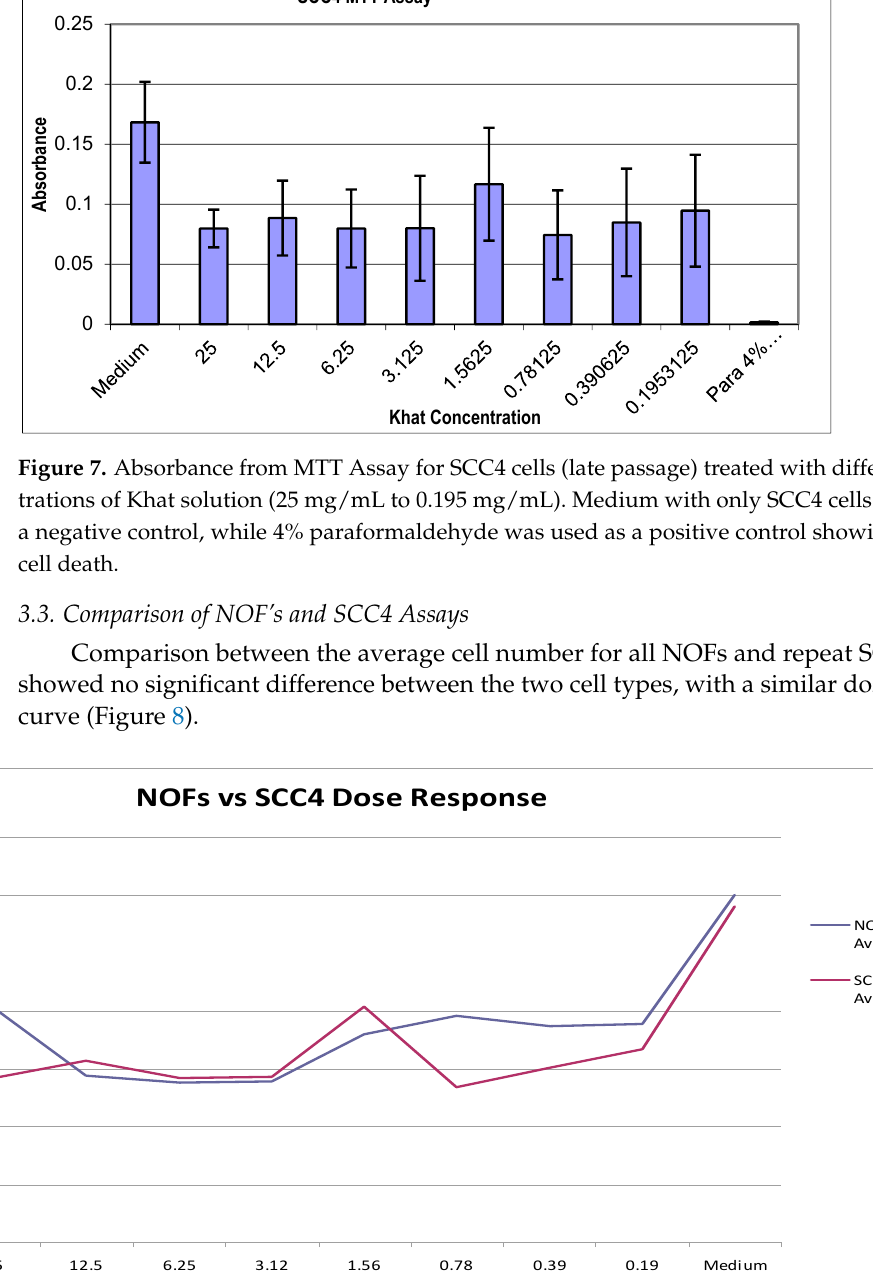
Figure 6. Absorbance from MTT Assay for SCC4 cells treated with different concentrations of Khat solution (25 mg/mL to 0.195 mg/mL). Medium with only SCC4 cells was used as a negative control while 4% paraformaldehyde was used as a positive control, showing complete cell death.